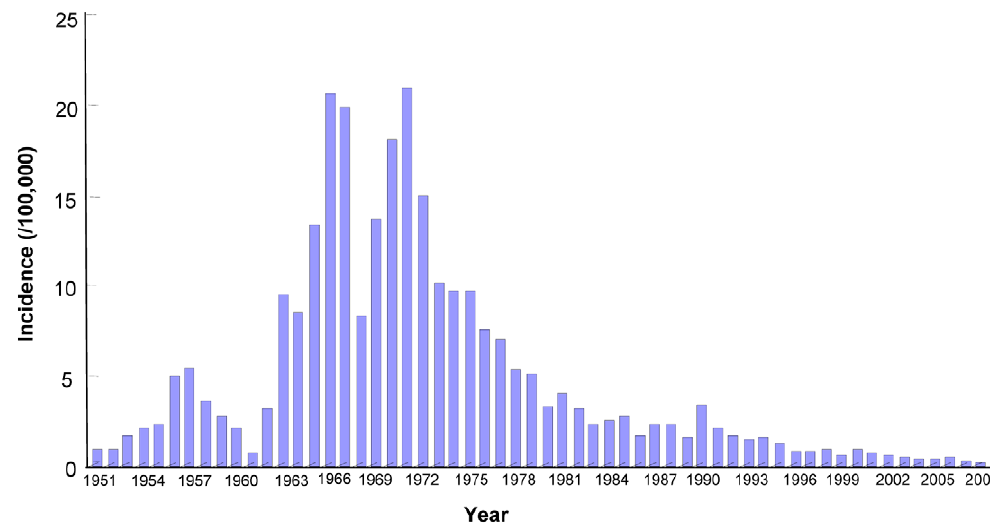
Figure 1. JE incidence from 1951–2008 in mainland China.